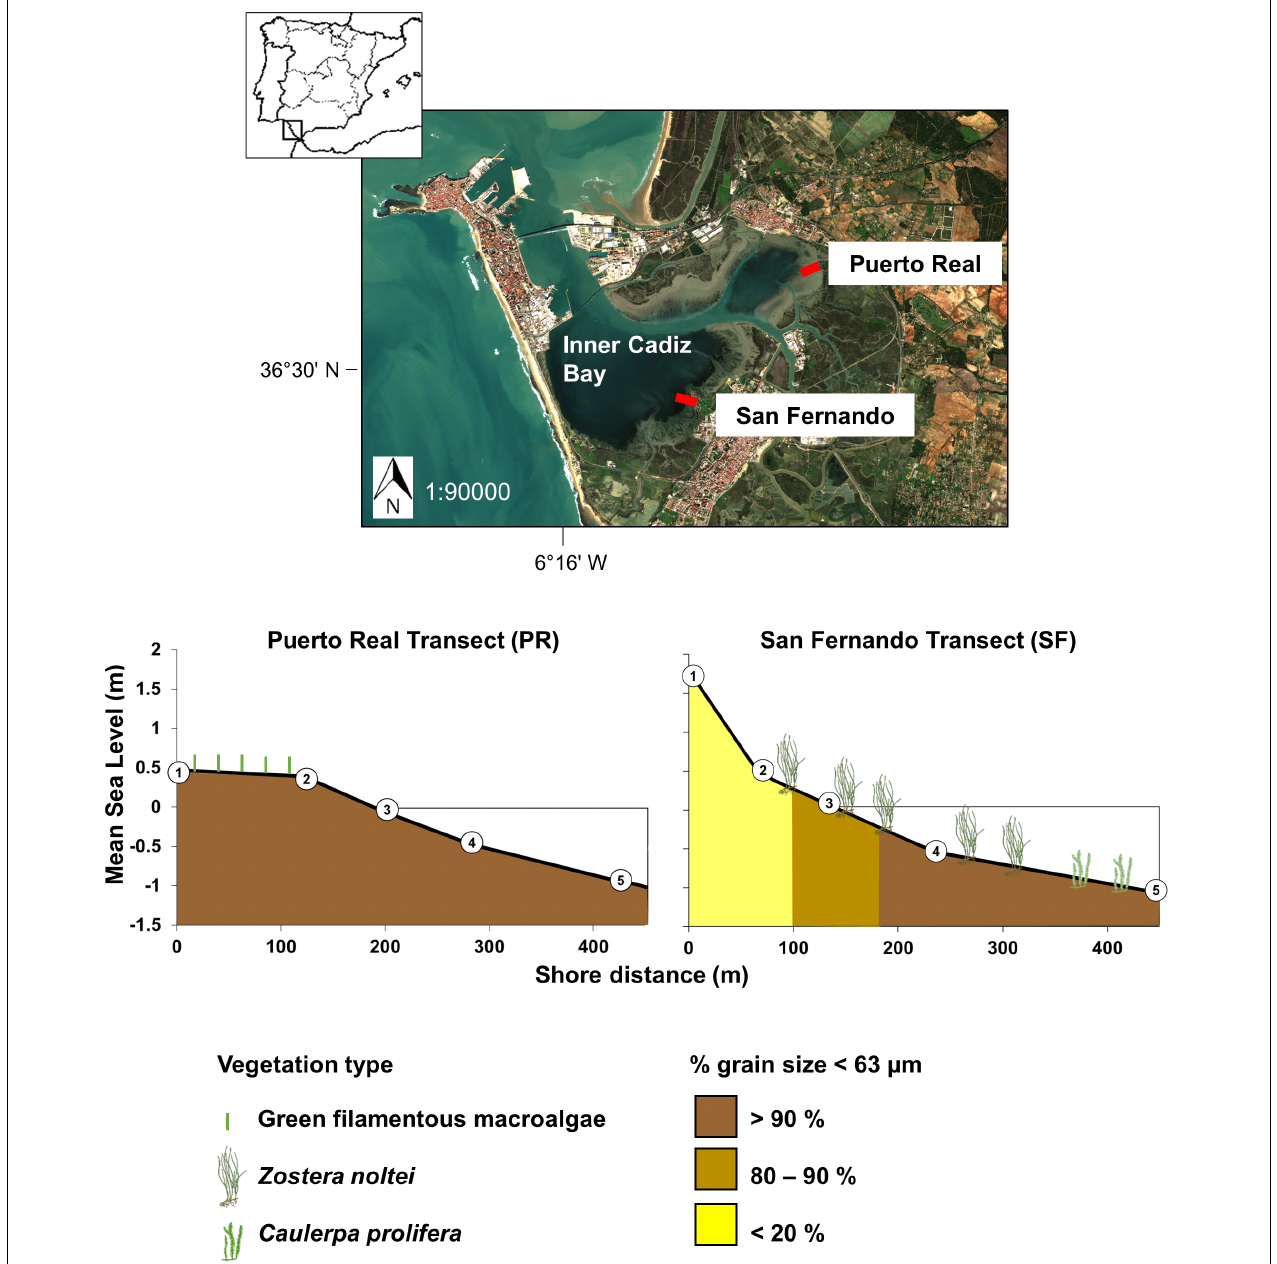
FIGURE 1 | Map of inner Cadiz Bay indicating the two studied transects: Puerto Real (PR) and San Fernando (SF). The lower panels indicate the slope profiles of each transect and the sampling stations as a function of shore distance (axis x ) and mean sea level (axis y ). The approximate distribution of grain size distribution ( < 63 µ m) and vegetation species zonation are